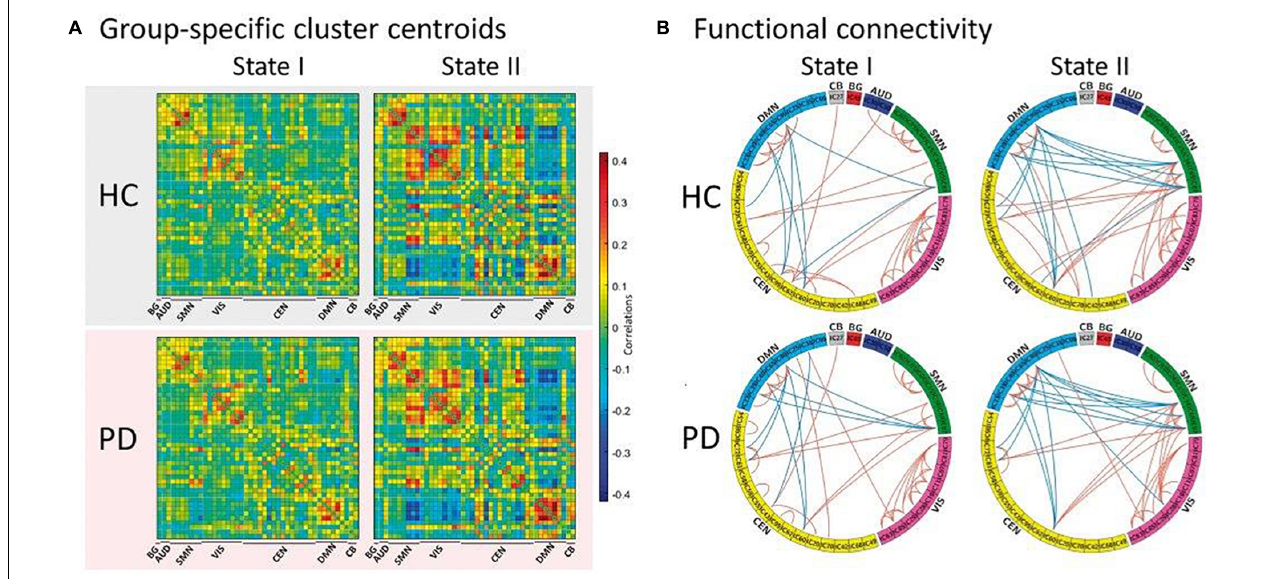
FIGURE 2 | Functional connectivity state results. (A) Group-specific cluster centroid for each state, averaged across subject-specific median cluster centroids of each group [percentage of total occurrences for stage I and II: 83.4% and 16.6% in the healthy controls (HC) and 70.8% and 29.2% in the Parkinson’s disease (PD) group, respectively]. (B) Functional connectivity in each state is shown for healthy controls and Parkinson’s disease groups, representing the 5% of the functional connectivity network with the strongest connections. BG, basal ganglia; AUD, auditory; SMN, sensorimotor; VIS, visual; CEN, cognitive executive; CB, cerebellar network (reproduced with permission from Kim et al.,